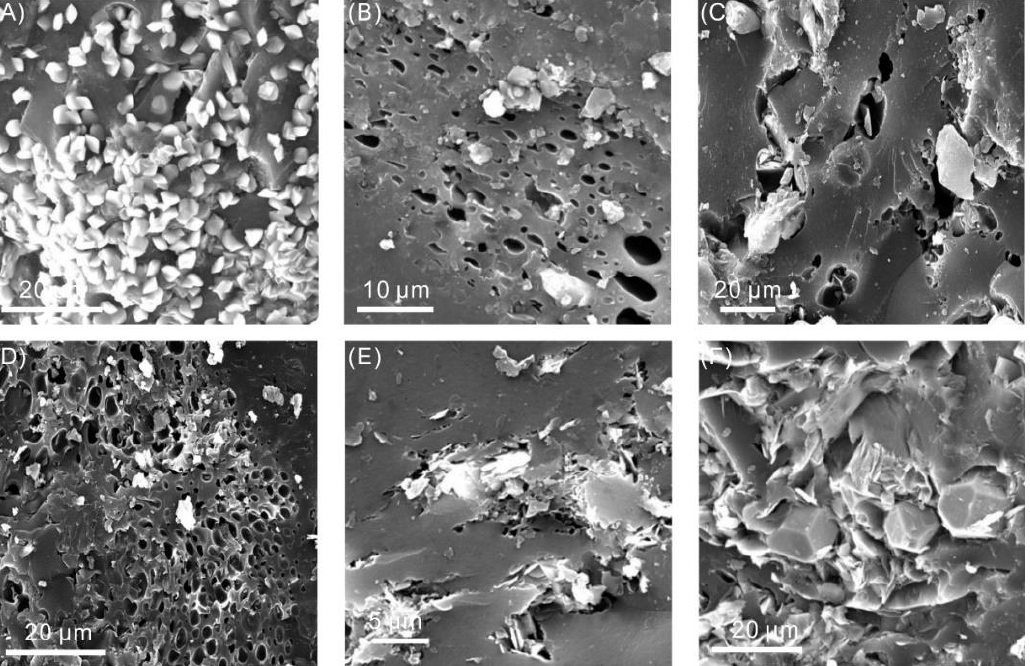
Figure 2. SEM images showing types of pores in a coal sample. ( A ) SX006-15, 1095 m, residual pores filled with quartz; ( B ) SX017-3, 993 m, pores in filamentous bodies; ( C ) BF3-1, 765 m, pores filled with kaolinite; ( D ) WZ3-3, 232 m, matrix micropores; ( E ) SGJ-15, 286 m, pores filled with kaolinite-illite; ( F ) WTP-15, 644 m, plant cell pores filled with pyrite.